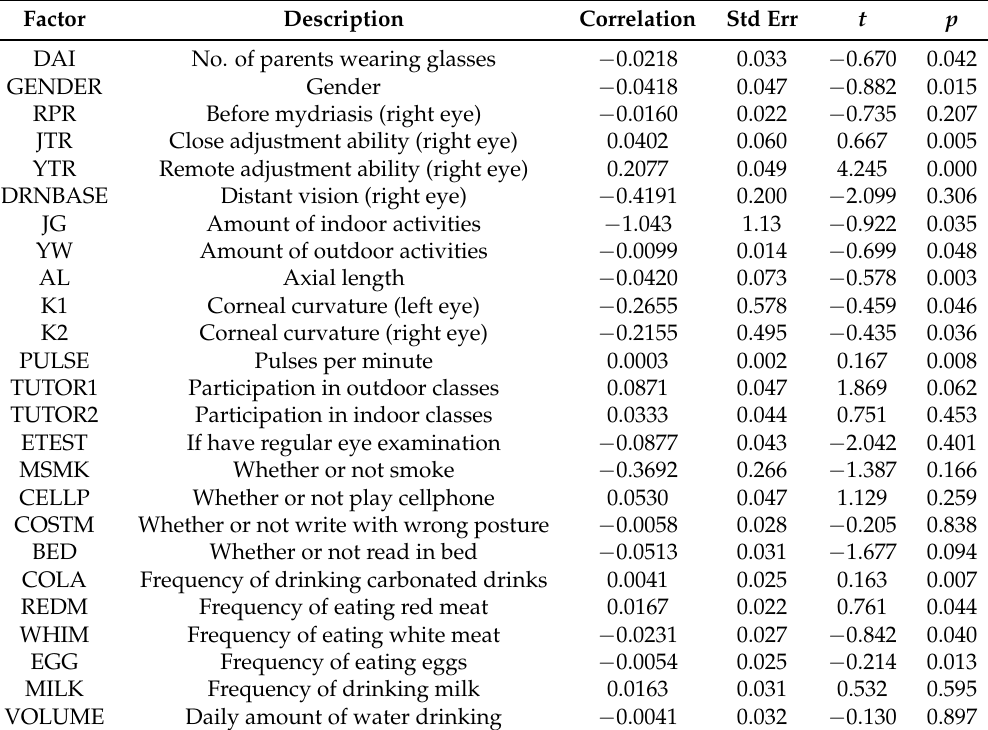
Table 2. Results of multivariate correlation